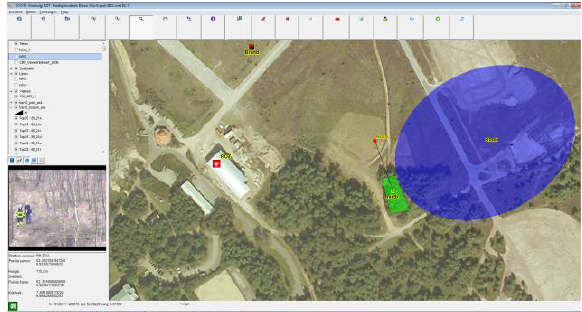
Figure 4. CCS-M crisis management system with video integrated imagery and